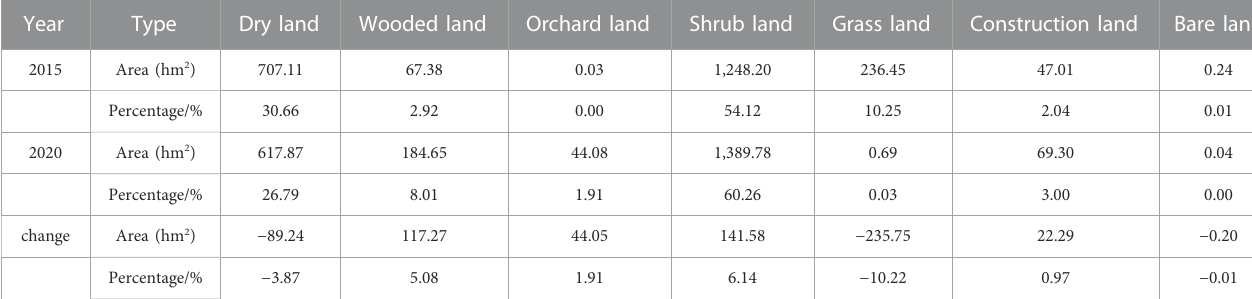
TABLE 3 Status of land use in the study area 2015 – 2020.